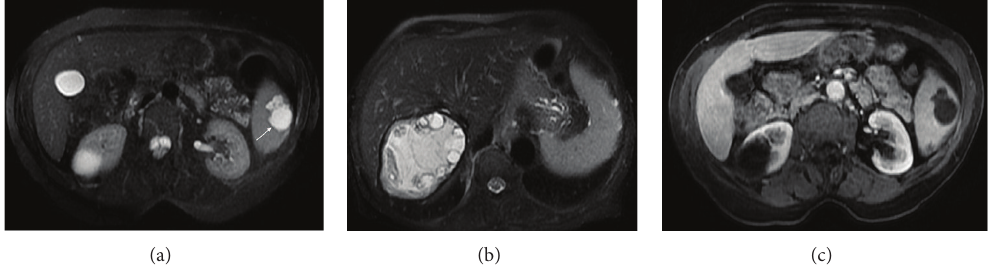
Figure 12: Hydatid cyst. Axial T2wi SSFSE with fat suppression ((a) and (b)) and axial postcontrast T1wi 3D-GRE with fat suppression in the venous (c) phase. A classic hydatid cyst is visualized in the liver (b). A concomitant splenic hydatid cyst is depicted as a multilocular lesion with moderate hyperintensity on T2wi (arrow, (a)) and hypointensity on T1wi (c). A fibrotic thickened continuous low signal intensity rim surrounding the cyst is seen on T2wi ((a), (b)). No enhancement is noted following IV contrast administration (c).